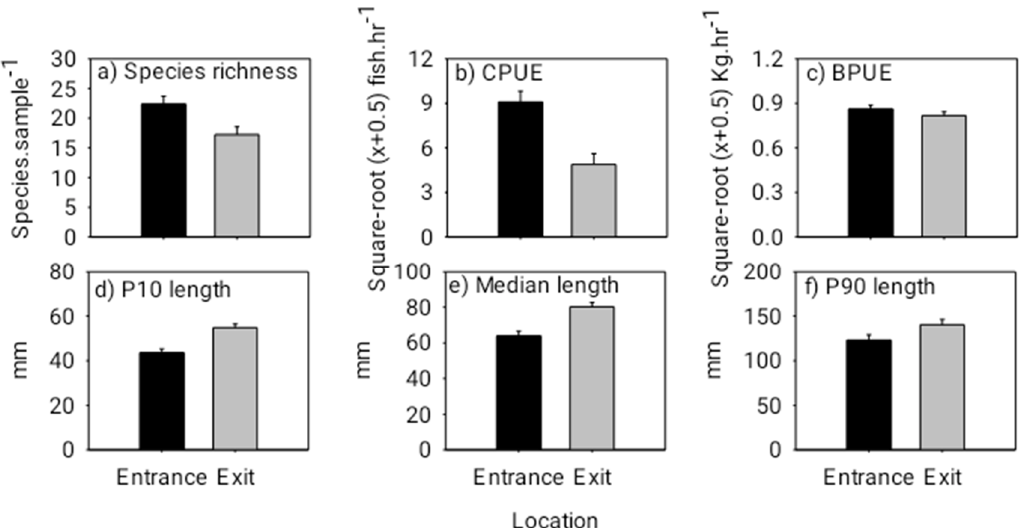
Figure 3. Mean (+ 1 SE) species richness (species sample − 1 ) ( a ), mean (+ 1 SE) abundance (catch per unit effort (CPUE) in catch hour − 1 ) ( b ), mean (+ 1 SE) biomass (biomass per unit effort (BPUE) in kg hour − 1 ) ( c ), 10 th percentile (+ 1 SE) fish length ( d ), median (+ 1 SE) fish length ( e ) and 90 th percentile (+ 1 SE) fish length ( f ) (lengths pooled across all species) at the entrance and exit locations for the day experiment. Note, the black bars represent the downstream fishway entrance and the grey bars represent the upstream exit. Additionally, square root (x + 0.5) transformed values have been presented for CPUE and BPUE to correspond with the ANOVA tests. Table 1. Average prevalence (i.e., proportion of occurrence in samples) of species identified by SIMPER during the day experiment as important in contributing to between-treatment dissimilarity in community composition (based on presence-absence transformed community data). Each species contributed at least 2% of total dissimilarity and had a dissimilarity-to-standard deviation ratio of ≥ 1. Species Entrance Exit Dissimilarity Contribution